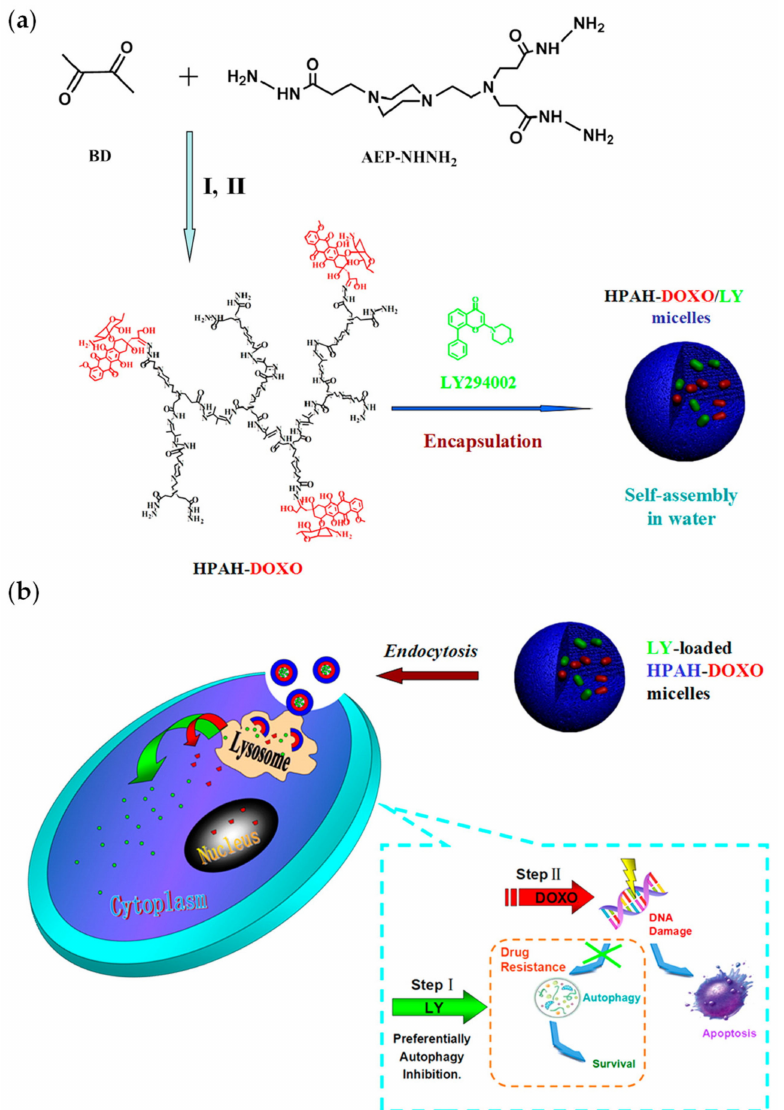
Figure 8. ( a ) Synthesis route of HPAH − DOXO and construction of the LY-loaded HPAH − DOXO micellar NPs. I, HPAH was synthesised via polycondensation of BD and AEP-NHNH2; II, conjugation reaction between DOXO and HPAH to obtain HPAH − DOXO. ( b ) Proposed mechanism of cellular uptake of the LY-loaded HPAH − DOXO micellar NPs and intracellular drug release. Modified with permission from Saiyin et al.